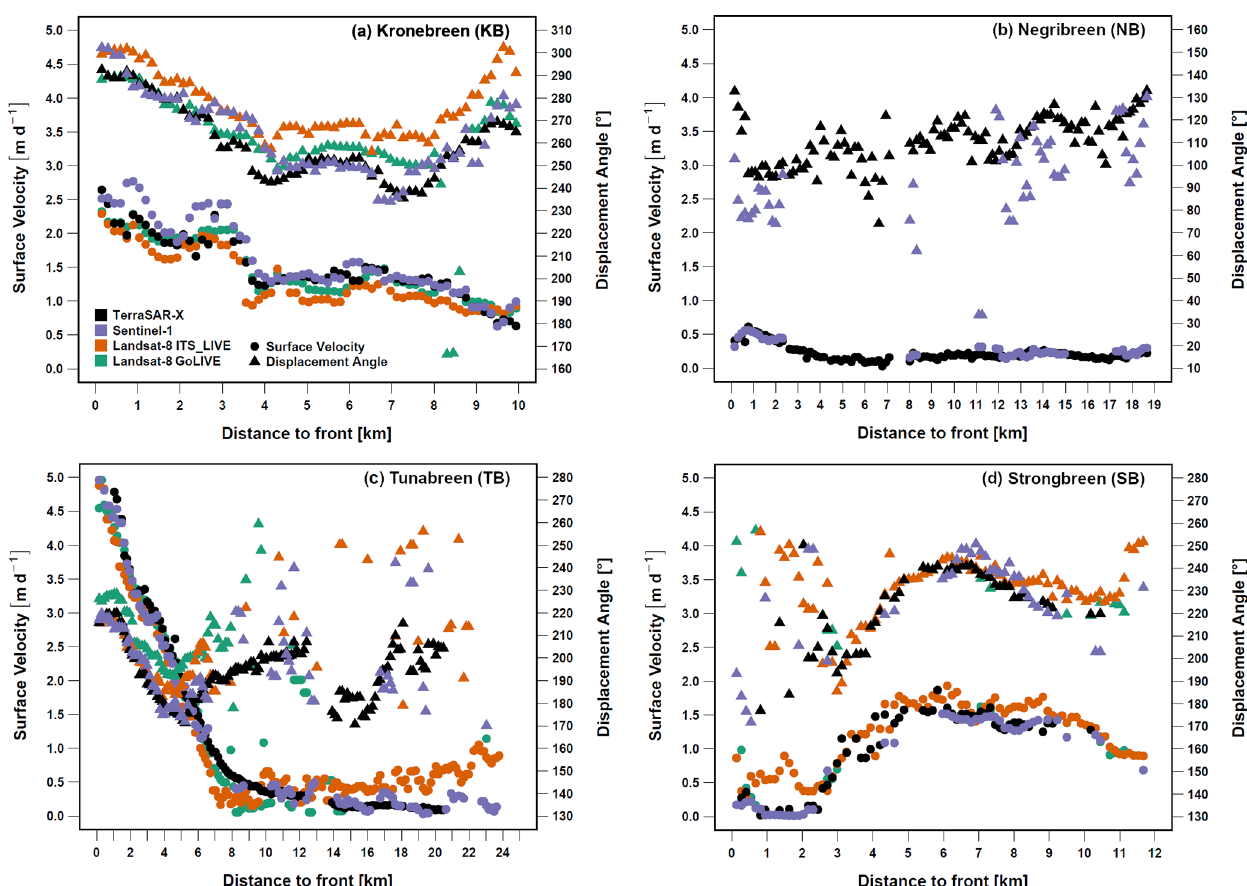
Figure 8. Comparison of velocity and displacement angle profiles from TerraSAR-X, Sentinel-1, Landsat-8 ITS_LIVE and Landsat-8 Go- LIVE data sets, extracted along the centerlines of four different glaciers in Svalbard. Centerlines are displayed in Fig. 7, and the dates of acquisition are listed in Table